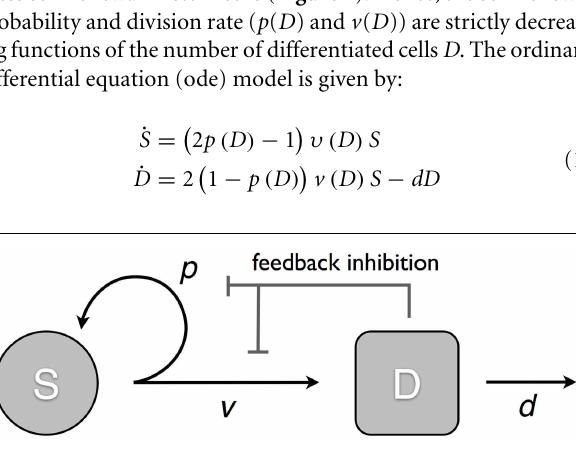
FIGURE 1 | Model of tissue regulation with feedback loops. S represents the stem cell population and D the differentiated cell population. Stem cells divide at a rate v ; this results in either two daughter stem cells with probability p ; or two differentiated cells with probability 1 − p. Differentiated cells die at rate d. The rate of cell division and the probability of self-renewal are decreasing functions of the number of differentiated cells [equation